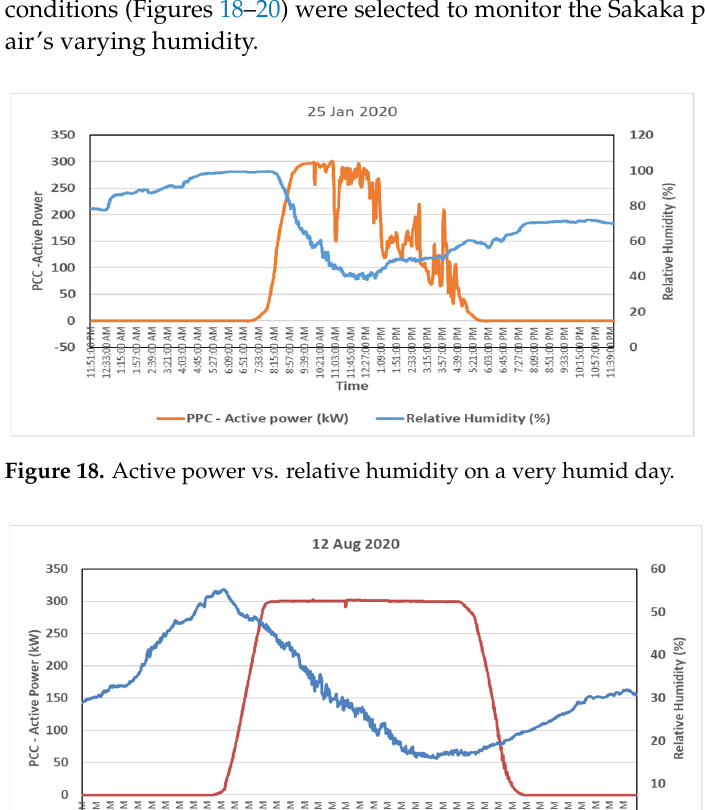
Figure 20. Active power vs. relative humidity on a least humid day. The output variation on a very humid day (25 January 2020) is represented using a graph in Figure 18. The percentage humidity from evening till early morning was at a high value, but as the day progressed, the humidity decreased. From Figure 18, we can infer that the power output is greater when the atmospheric humidity is low. In Figure 19, during a moderately humid day (12 August 2020) with a clear sky, the power output was close to almost 300 kW, and the humidity did not seem to affect the plant’s output. This is also similar to when the humidity level was at its lowest on a very sunny day, as seen in Figure 20, on 6 June 2020. We can infer from these results that a high level of hu ‐ midity does have a marginal effect on the output of PV modules during cloudy days. On a sunny day, however, low amounts of humidity under a clear sky do not affect the pro ‐ duction of PV modules.